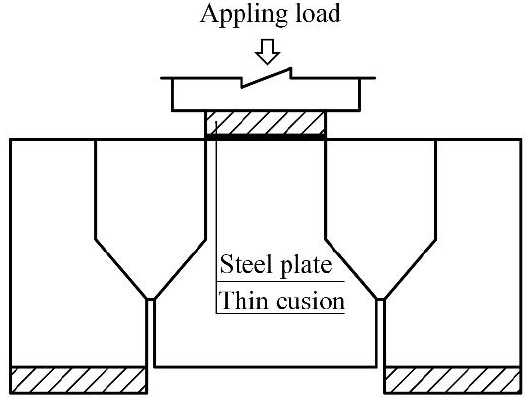
Figure 3. Test setup for bi-shear method.